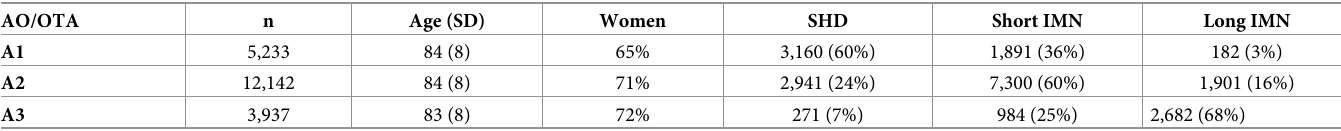
Table 1. Distribution of the 21,312 trochanteric hip fractures in the study cohort according to the AO/OTA classification. Number of fractures, mean age (SD), sex distribution (% women), treatment n (%) as sliding hip device (SHD) and short or long intramedullary nail